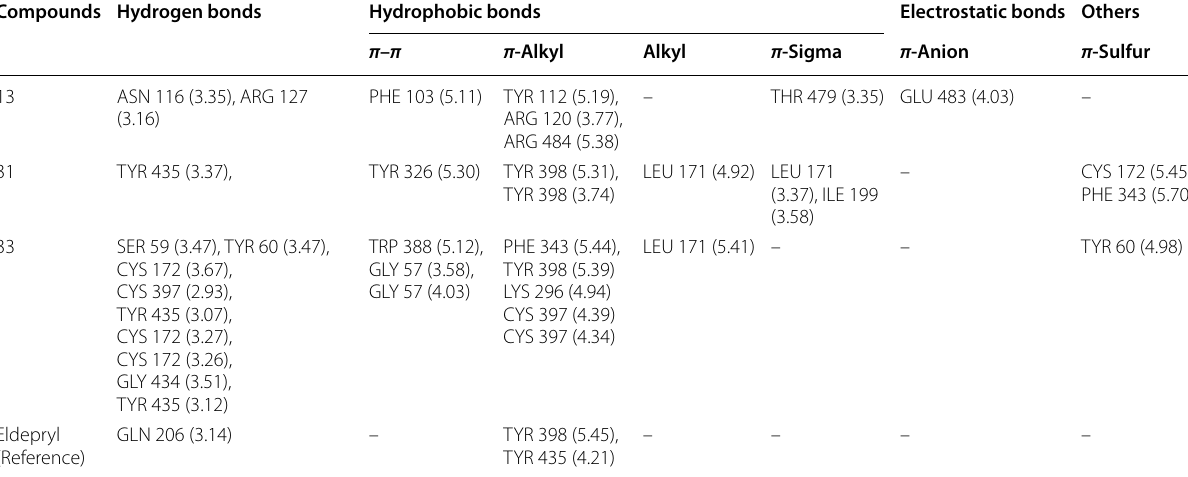
Table 7 Detailed binding interactions of compounds with the protein with distances in (Å) Compounds Hydrogen bonds